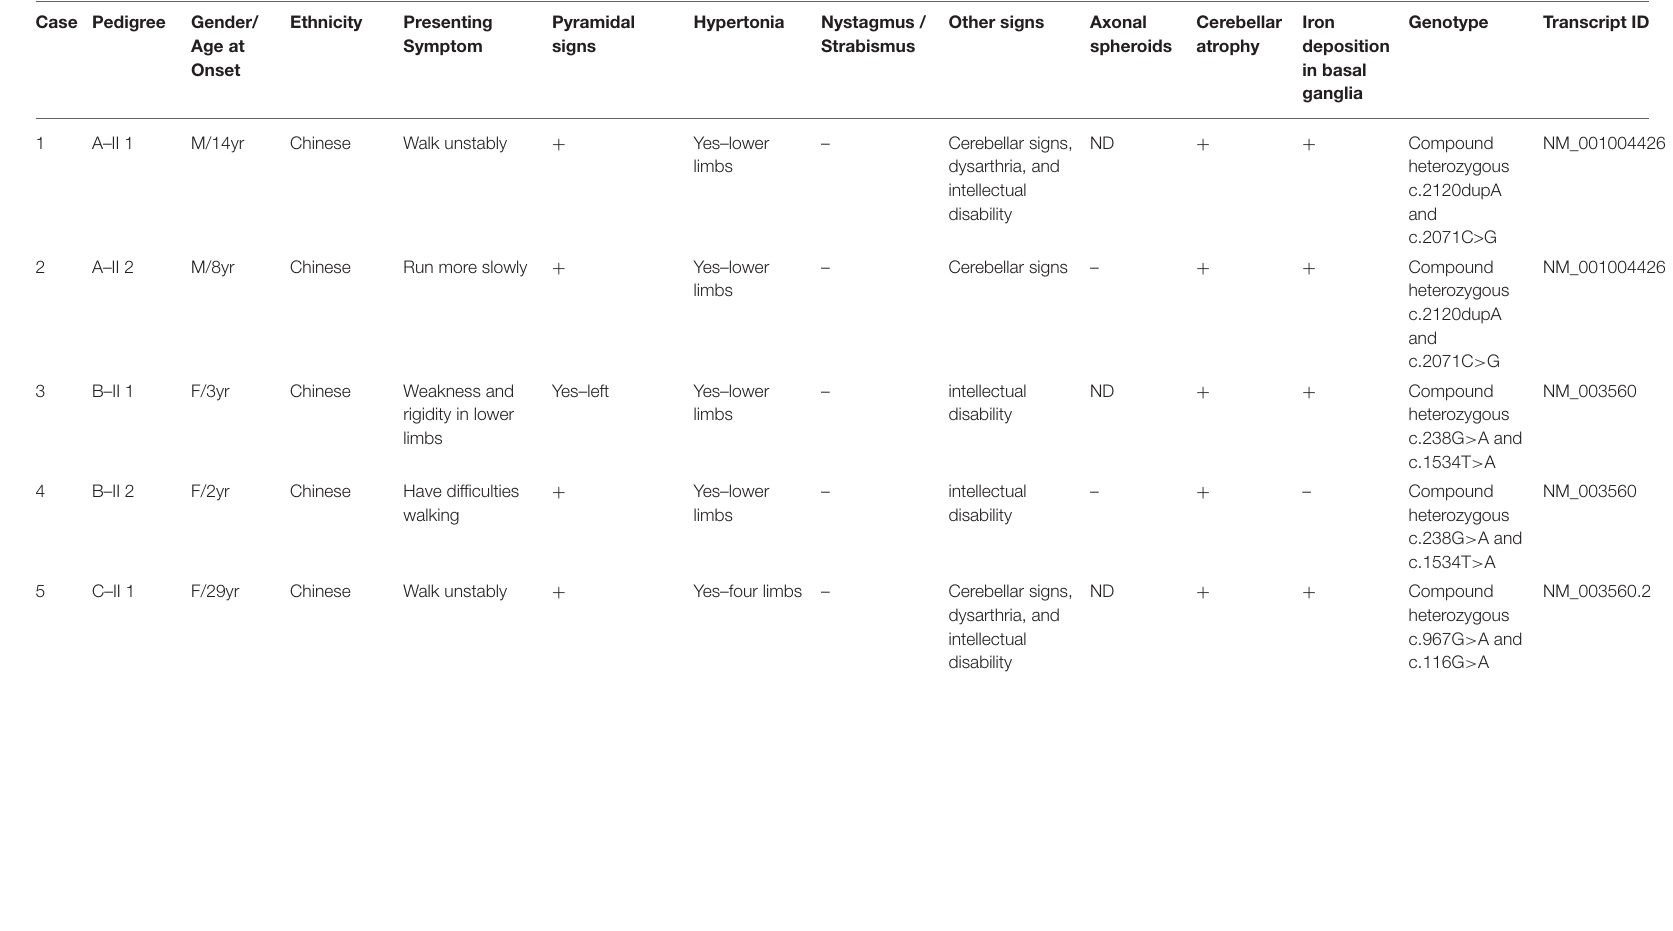
TABLE 1 | Clinical features of the five PLAN patients in this